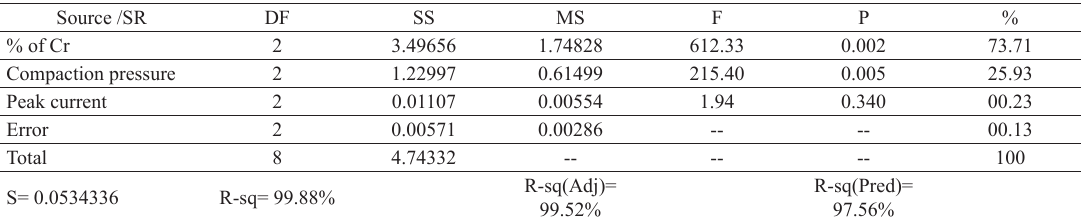
Table 4. Variance analysis for SR.